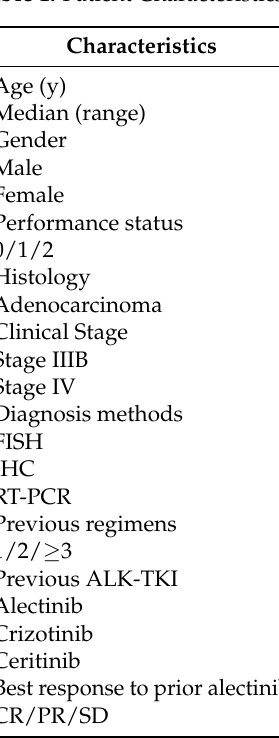
Table 1. Patient